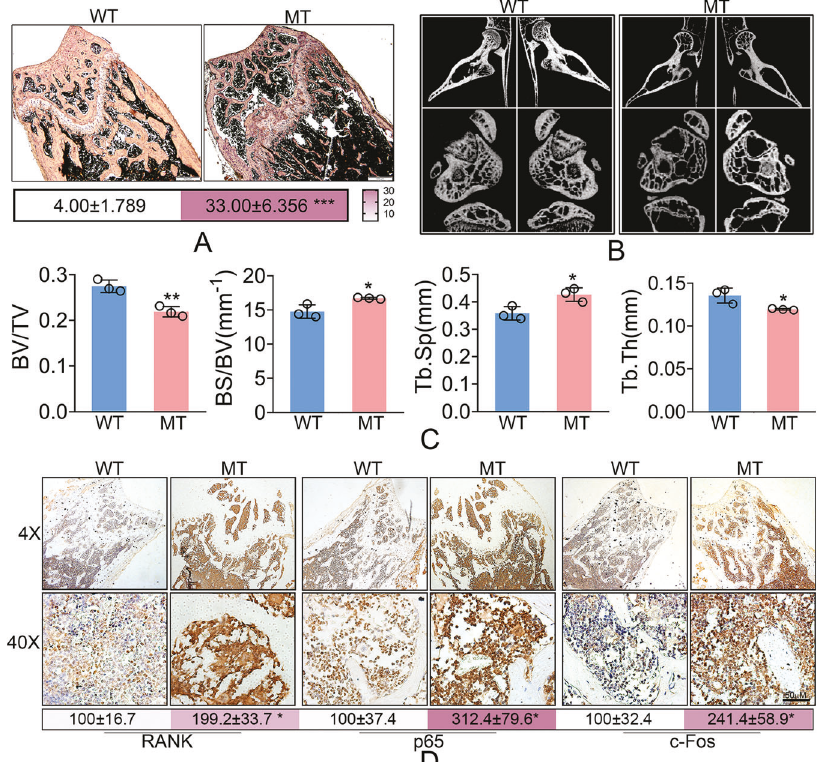
Fig. 4 The Hoxd13 mutation caused bone loss in vivo. A The effect of Hoxd13 mutation on the osteoclast differentiation in bone tissues. B In vivo imaging of the tibia and femur from mice carrying wild and mutant Hoxd13 by micro-CT. C The BV/TV, BS/BV, Tb.Sp, and Tb.Th obtained using micro-CT. * p < 0.05; ** p < 0.01. D Immunohistochemistry assay was used to determine the expression of Rank, p65, and c-Fos in bone tissues. * p < 0.05. All experiments were repeated three